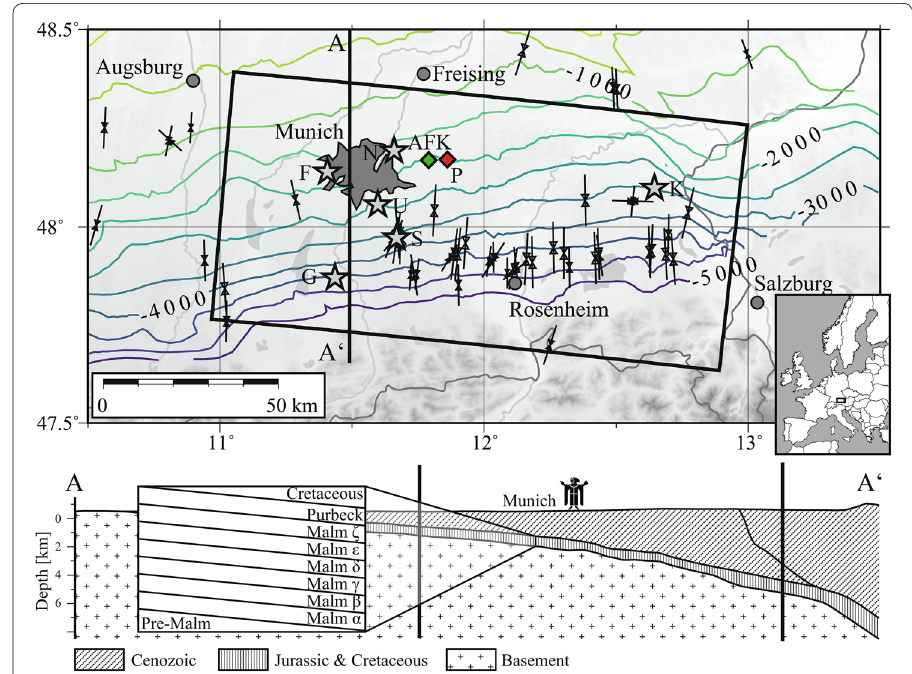
Fig. 1 Map of the eastern Bavarian Molasse Basin. Depths (b.s.l.) of top Malm delta is indicated by coloured isolines (Przybycin et al. 2017). Model area is indicated by the rectangular box. Orientations of the maximum horizontal stress S Hmax indicated by lines and symbols are from the World Stress Map database release 2016 (Heidbach et al. 2016). Disclosed stress magnitude data records used for the model calibration are indicated by stars in Freiham (F), Unterhaching (U), Sauerlach (S), Geretsried (G), Unterföhring (N), and Kirchweidach (K). The two neighbouring geothermal projects that are discussed are indicated by diamonds in Poing (P, red) and Aschheim/Feldkirchen/Kirchheim (AFK, green). The cross‑section A – A ′ shows the model geometry and the realised lithological